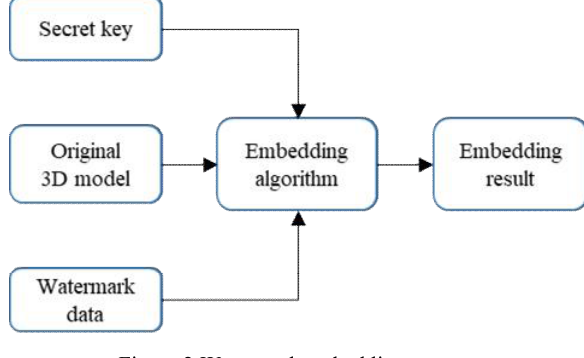
Figure 2.Watermark embedding